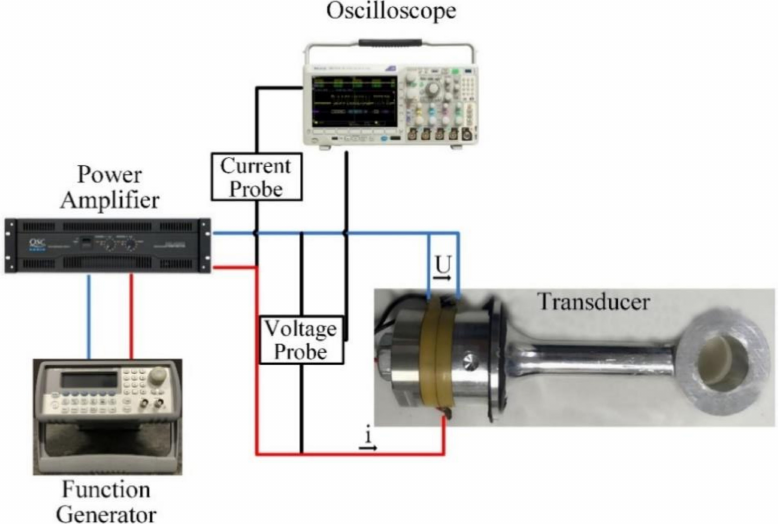
Figure 4. The experimental setup of cavitation processing for cylindrical workpieces.